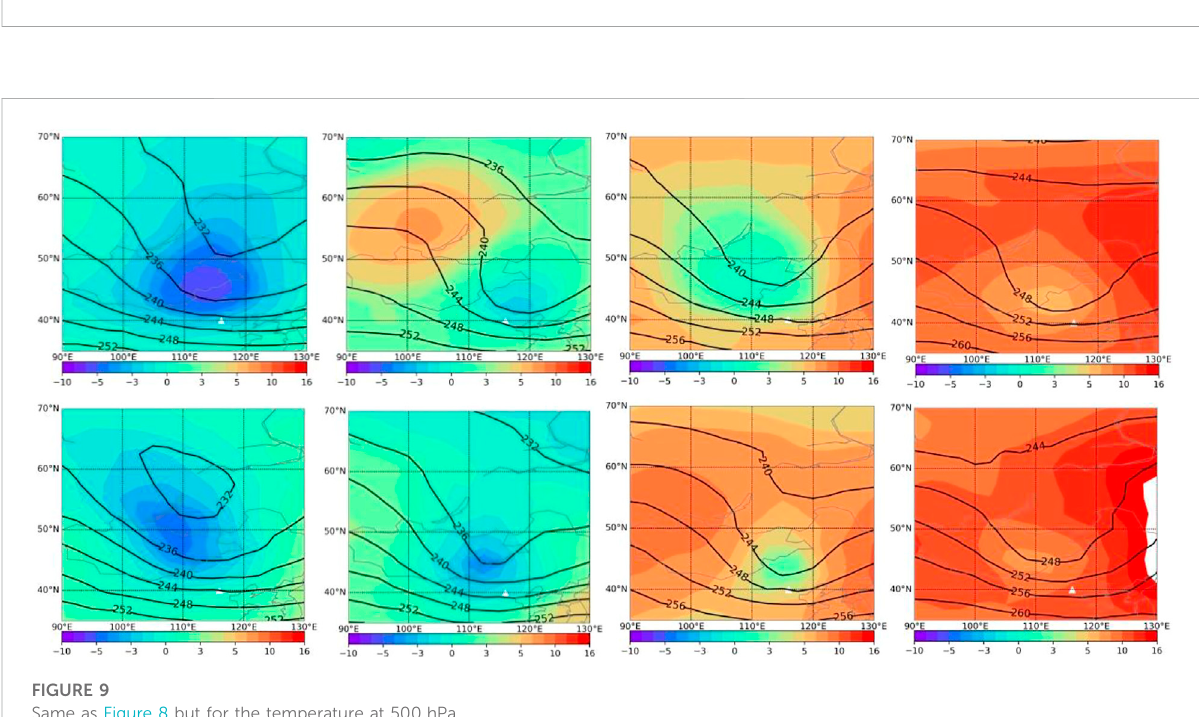
FIGURE 9 Same as Figure 8 but for the temperature at 500